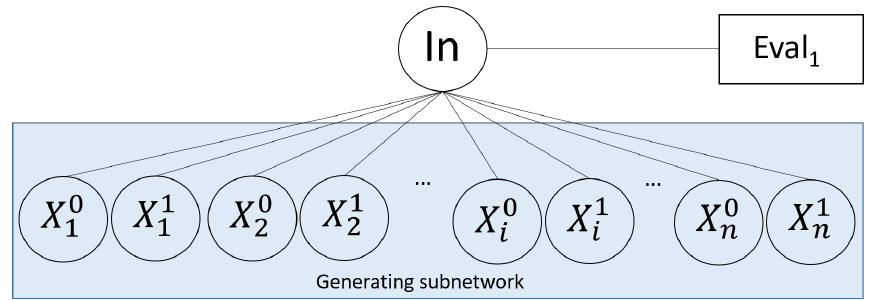
Figure 2. Subnetwork Gen